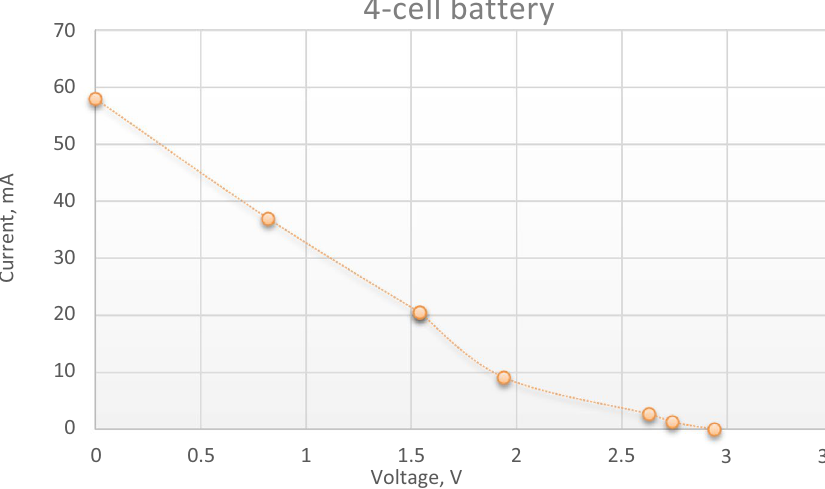
Fig. 3 Prototype of a multi-cell flexible textile Al-Air battery with cells arranged on a plane Fig. 4 Current–Voltage charac- teristic of a 4-cell